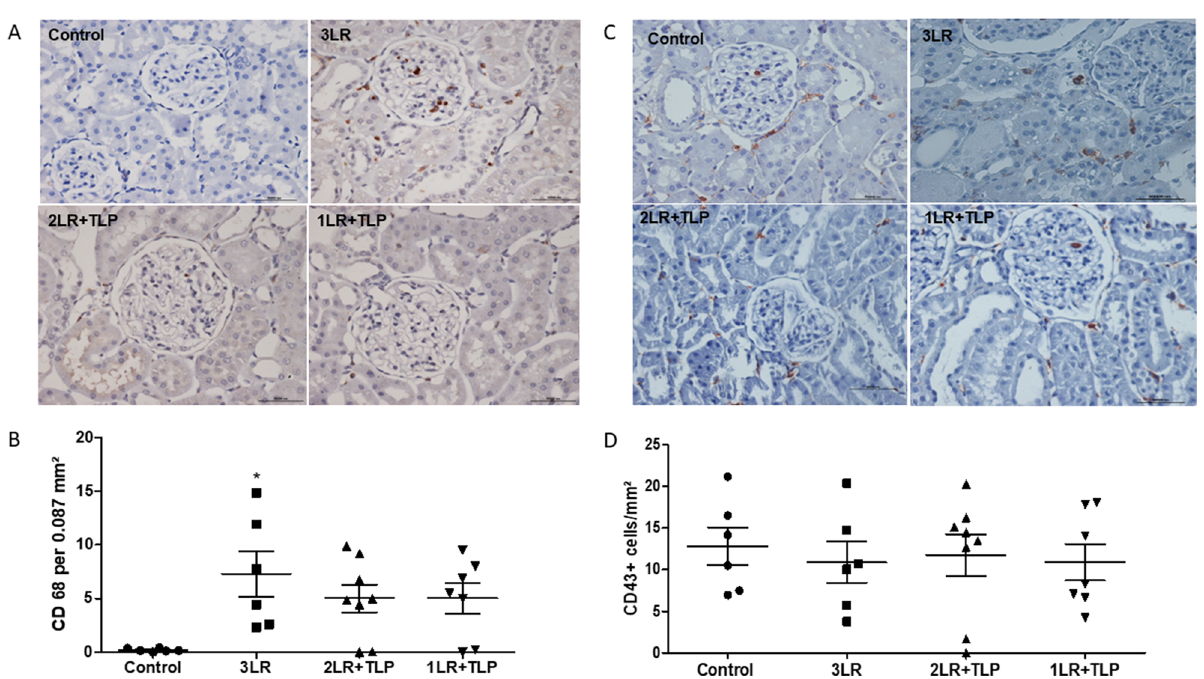
Figure 7. Immunohistochemical analysis of CD68 expression in rat kidney tissue. Immunostaining [brown, in ( A )] for CD68 in kidney cortex samples from control, 3LR, 2LR + TLP, and 1LR + TLP group rats. Magnification, × 400. ( B ) Bar graph of CD68 expression. Immunohistochemical analysis of CD43 expression in rat kidney tissue. Immunostaining [brown, in ( C )] for CD43 in kidney cortex samples from control, 3LR, 2LR + TLP, and 1LR + TLP group rats. Magnification, × 400. ( D ) Bar graph of CD43 expression. * P < 0.05 vs. control; Control, no intervention; 3LR, induction of hemorrhagic shock, followed by infusion of lactated Ringer’s at 3 times the volume of the blood withdrawn; 2LR + TLP, induction of hemorrhagic shock, followed by infusion of lactated Ringer’s at 2 times the volume of the blood withdrawn, together with intravenous injection of terlipressin at 10 µg/100 g body weight; 1LR + TLP, induction of hemorrhagic shock, followed by infusion of lactated Ringer’s at a volume equal to that of the blood withdrawn, together with intravenous injection of terlipressin at 10 µg/100 g body